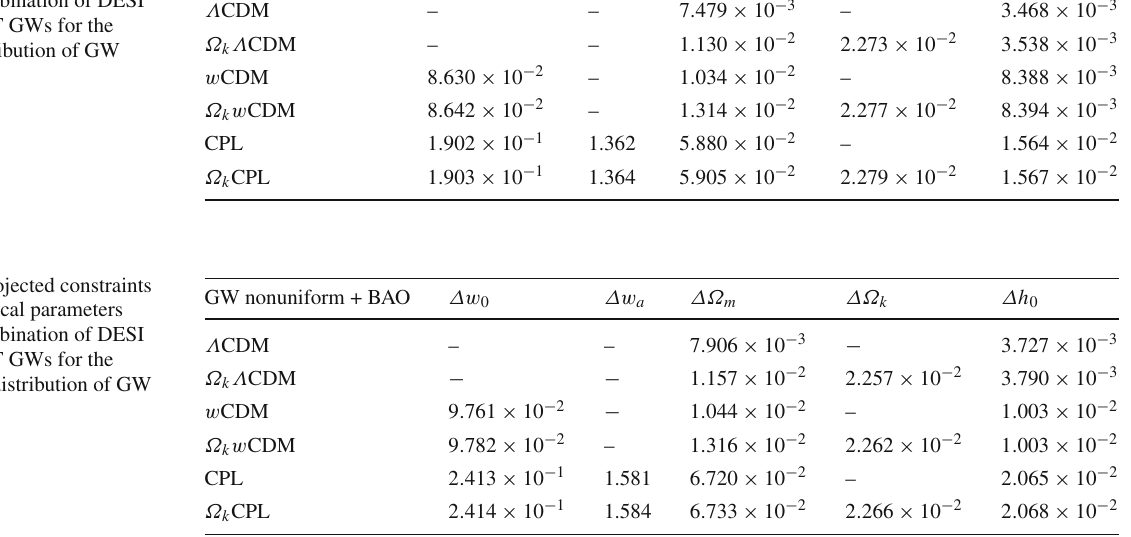
on cosmological parameters from the combination of DESI BAOs and ET GWs for the uniform distribution of GW sources